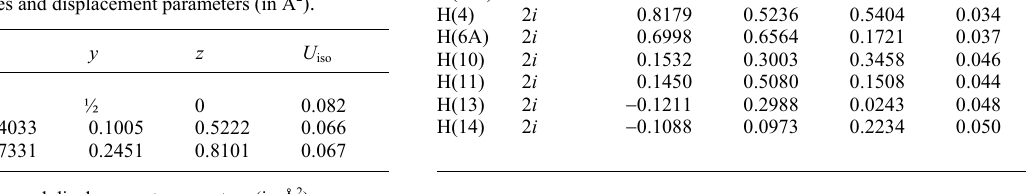
Table 2. Atomic coordinates and displacement parameters (in Å 2 ) .